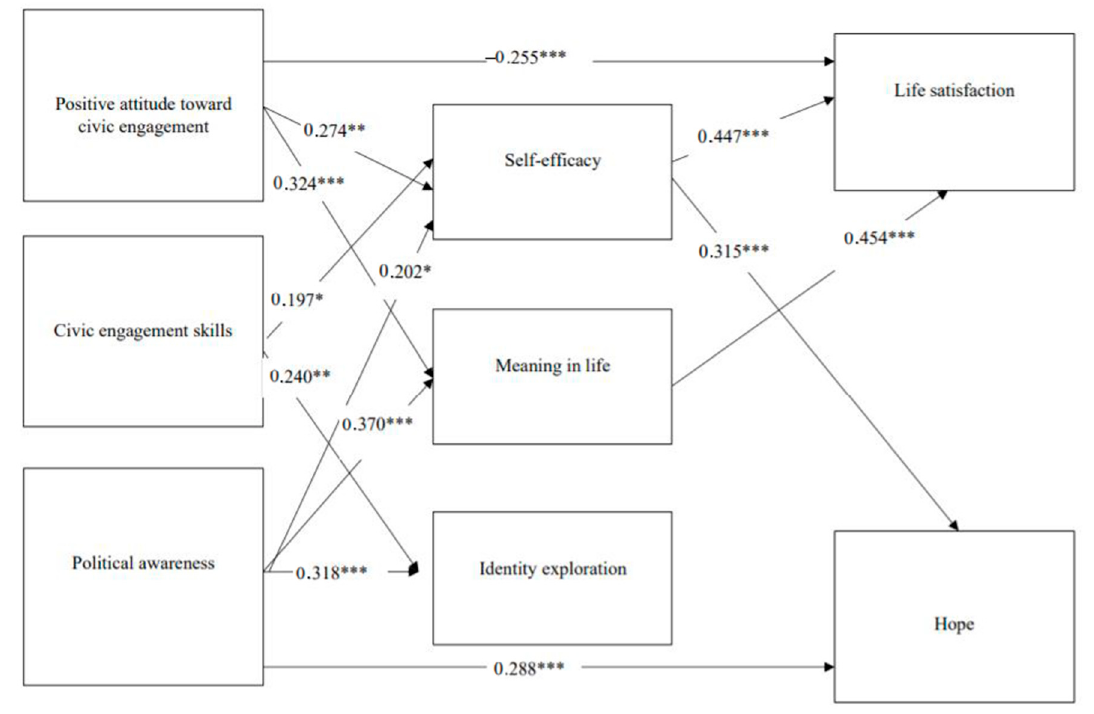
Figure 1. The results of the study model. * p < 0.05, ** p < 0.01, *** p < 0.001.